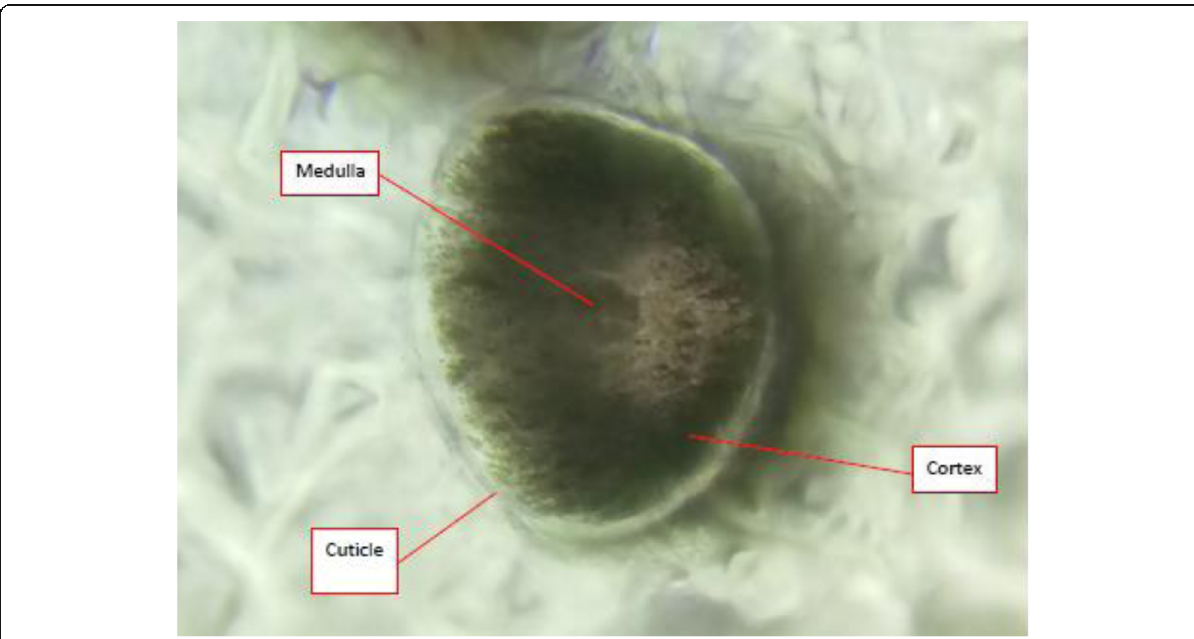
Fig. 1 Cross-section of human scalp hair observed under compound light microscope. Photo credit to Lee Yong Ming